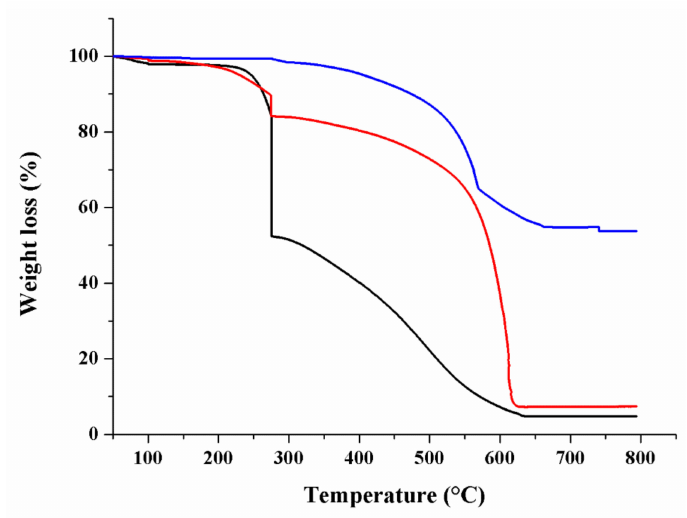
Figure 4. TGA thermograms of ox-MWCNT (blue line), CS (black line), and CS_MWCNT (red line) showing the e ff ect of polymer coating on the thermal stability of hybrid